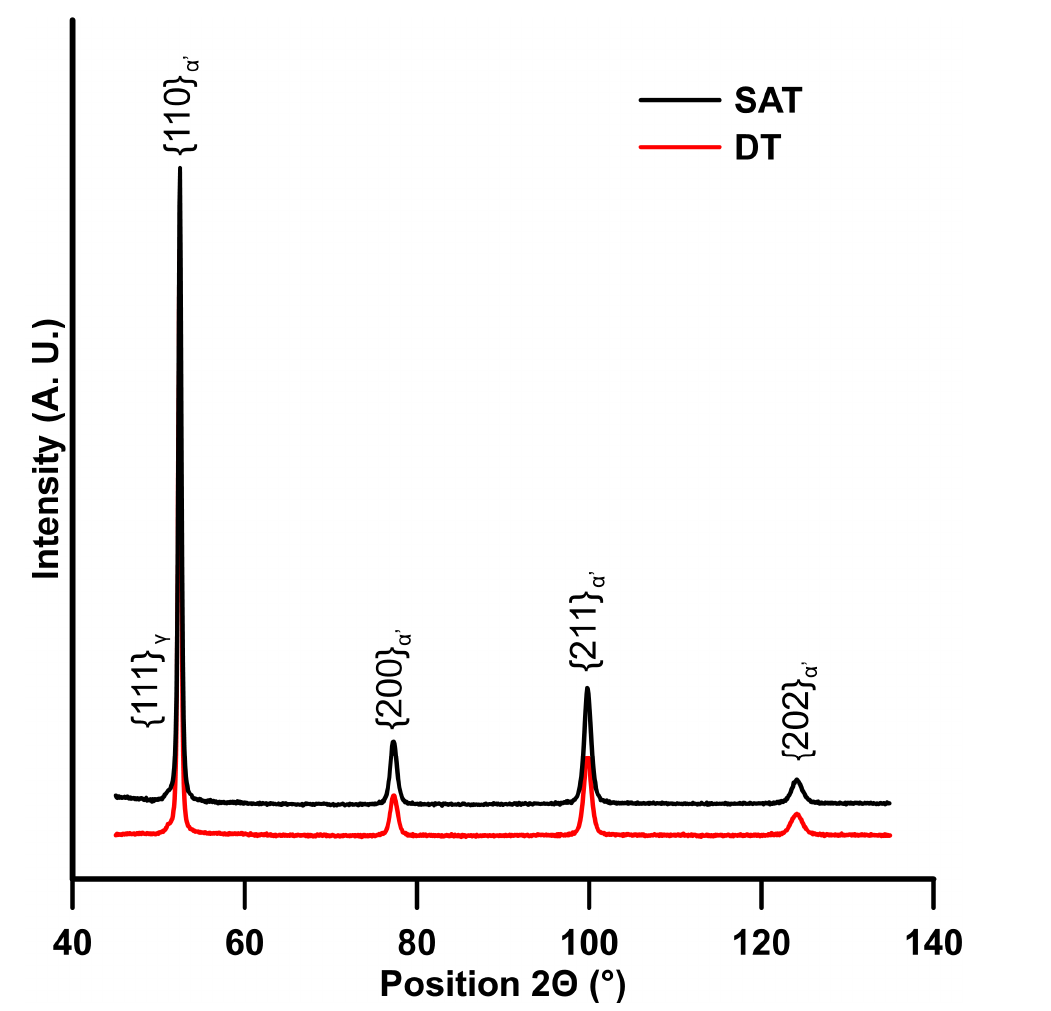
Figure 6. XRD patterns for the DT and SAT states.